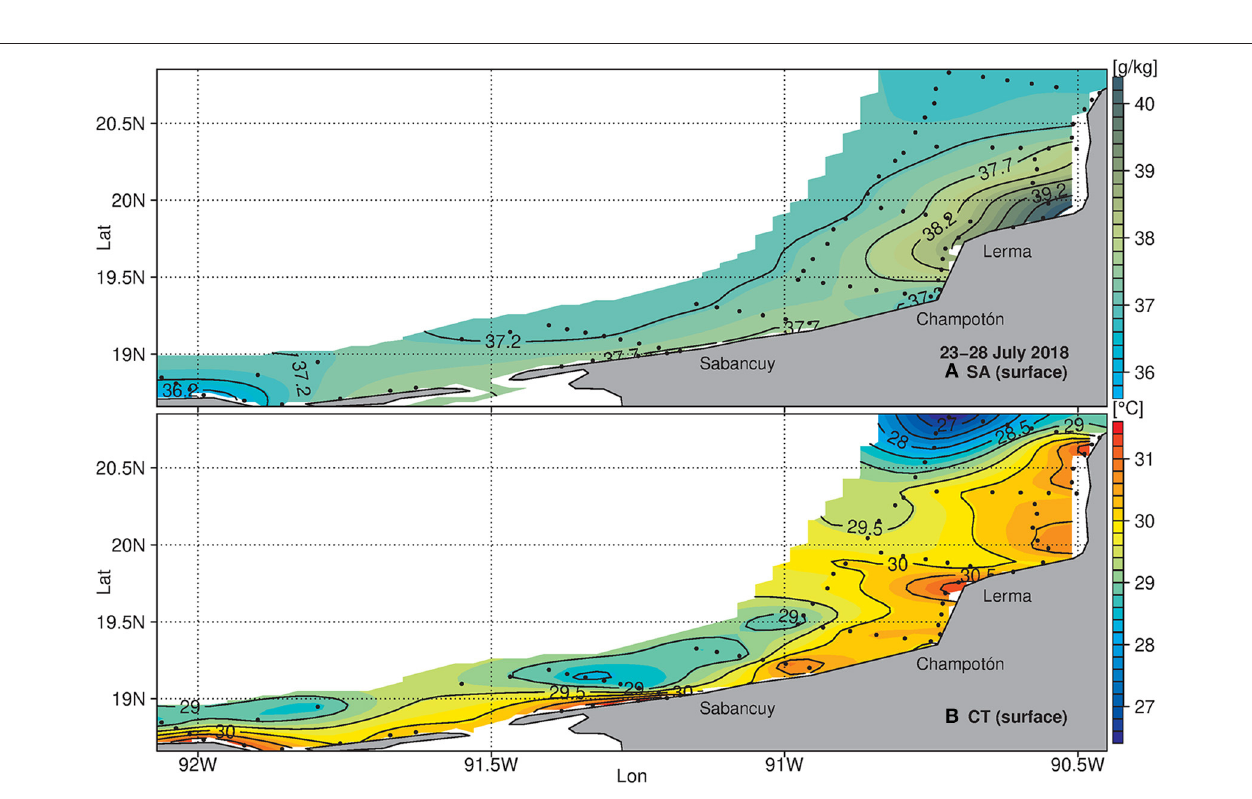
Frontiers in Marine Science |